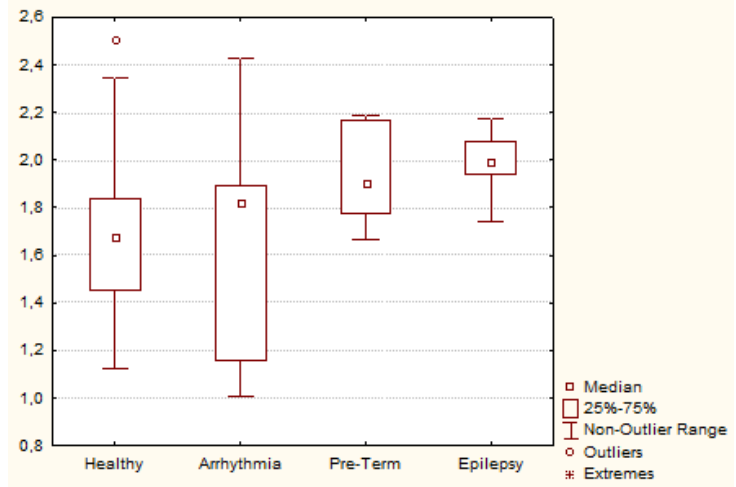
Figure 4. Box and Whisker plot illustrating BisQ values among different groups of ECG recordings. Comparisons between groups with the Mann-Whitney´s nonparametric test Table 5 revealed that the group of persons with epilepsy exhibited higher BisQ values than the group healthy persons healthy persons group. Table 5. P-values resulting from the Mann-Whitney U test for group comparisons using BisQ.